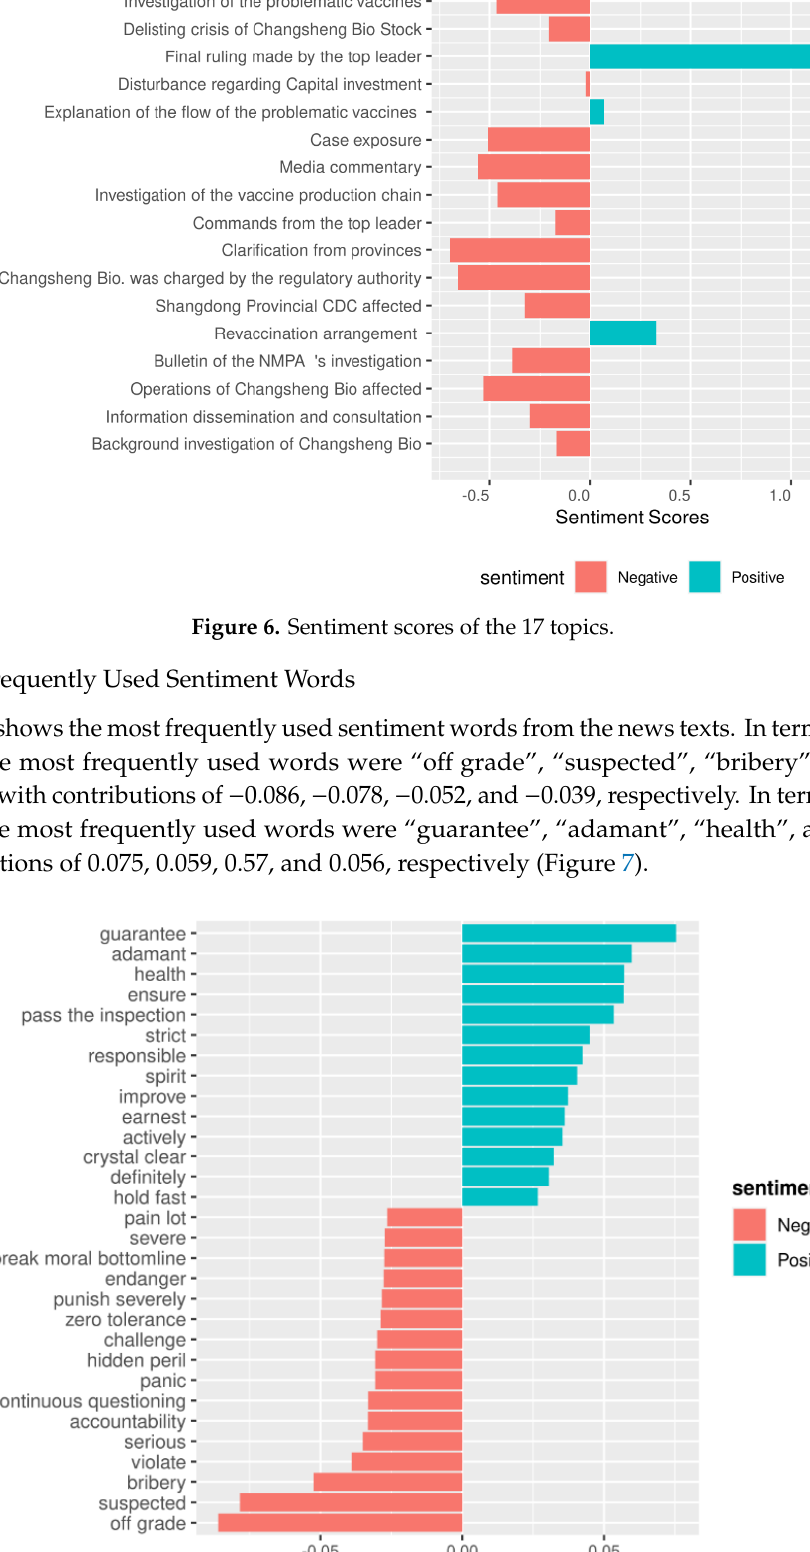
Figure 7. Sentiment words used most frequently in the